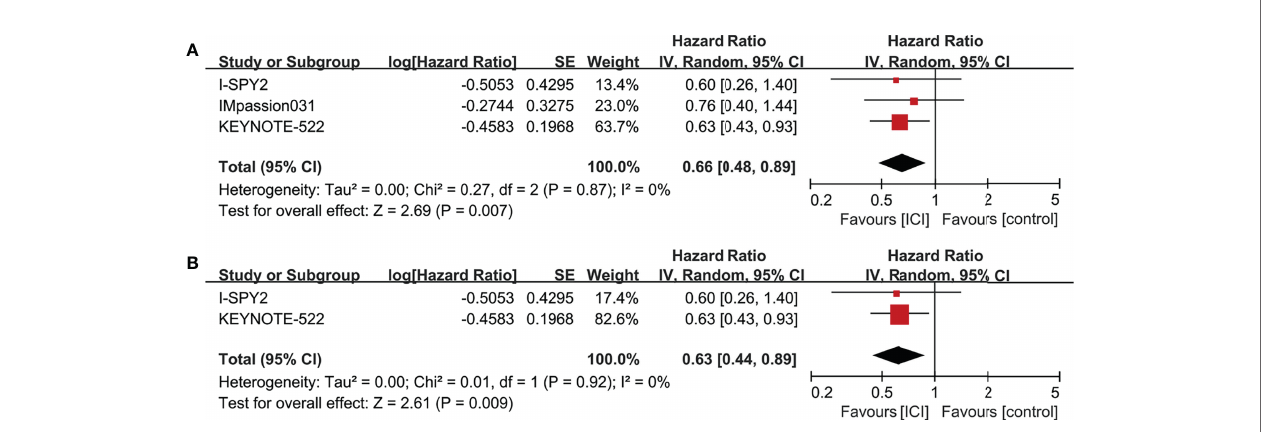
FIGURE 4 | Forest plots of meta-analyses for event-free survival (EFS). (A) ICI-containing neoadjuvant therapy compared with ICI-free neoadjuvant therapy for TNBC. (B) Anti-PD-1-containing neoadjuvant therapy compared with ICI-free neoadjuvant therapy for